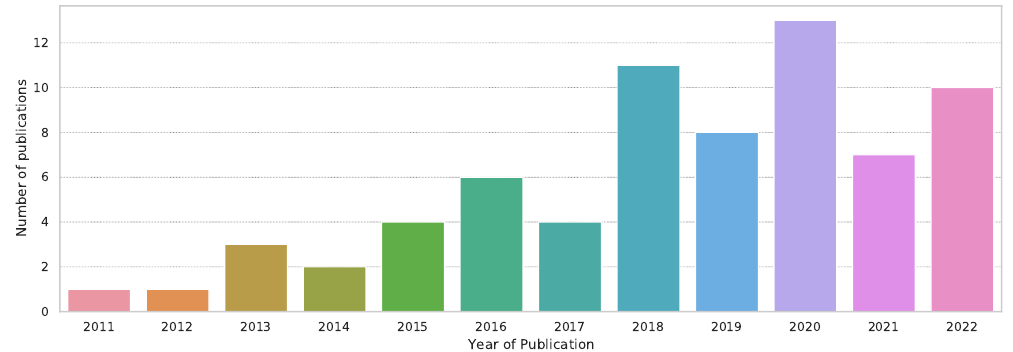
Figure 1. The number of published NILM reviews per